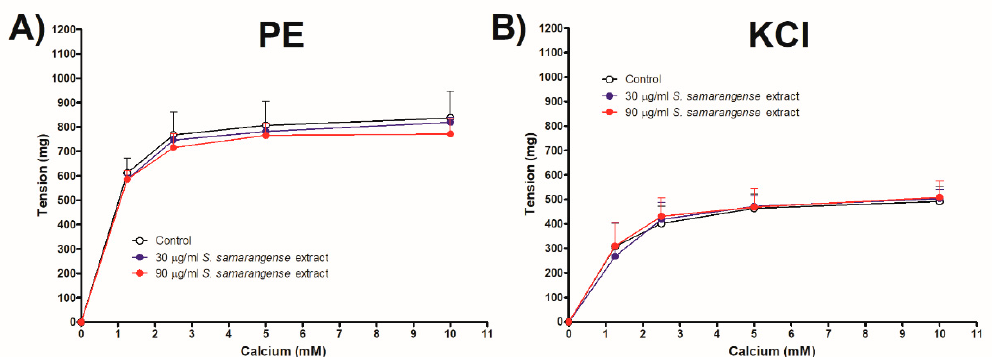
Figure 5. Dose response curve of CaCl 2 in a Ca 2+ -free Krebs solution in the presence or absence of various concentrations of S. samarangense extract (30 and 90 g/mL) ( A ) in phenylephrine (10 μ M) and ( B ) in KCl (80 mM)- induced constriction of endothelium-intact aortic rings, respectively. Results are displayed as the mean ± standard error of six animals.